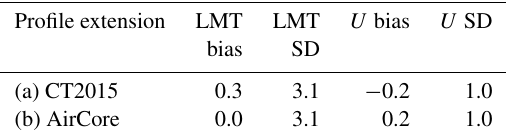
Table A5. Effect of profile extension, part 2. Extension of the air- craft with CarbonTracker versus extension with